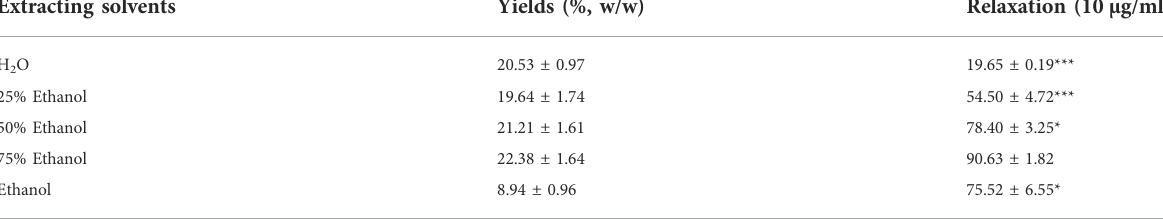
TABLE 1 Extraction yields, and relaxation of Lotus leaf with different extraction solvents.